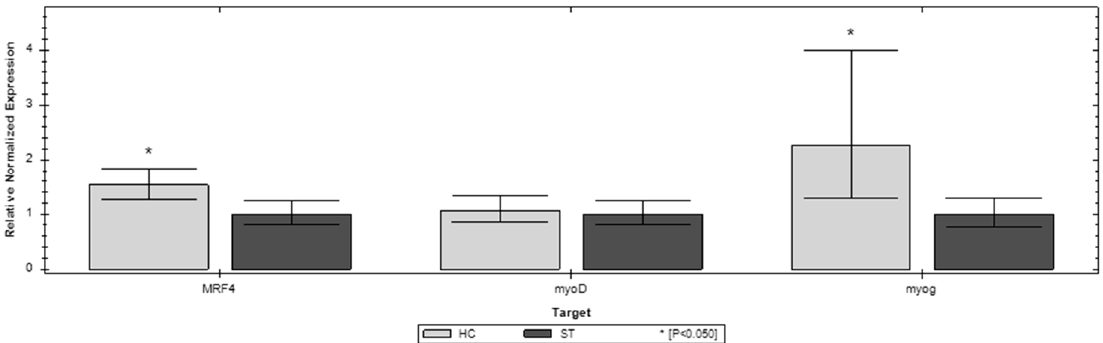
Figure 2. Relative expression of the MFR4, myoD, and myoG genes on the first day (D1) of life in the standard (ST) and HatchCare (HC) groups ( p = 0.049 for MRF4, p = 0.508 for myoD, and p = 0.048 for myog). Significant difference compared to ST (* p < 0.05). The figure was generated with CFX Maestro Software 2.3.